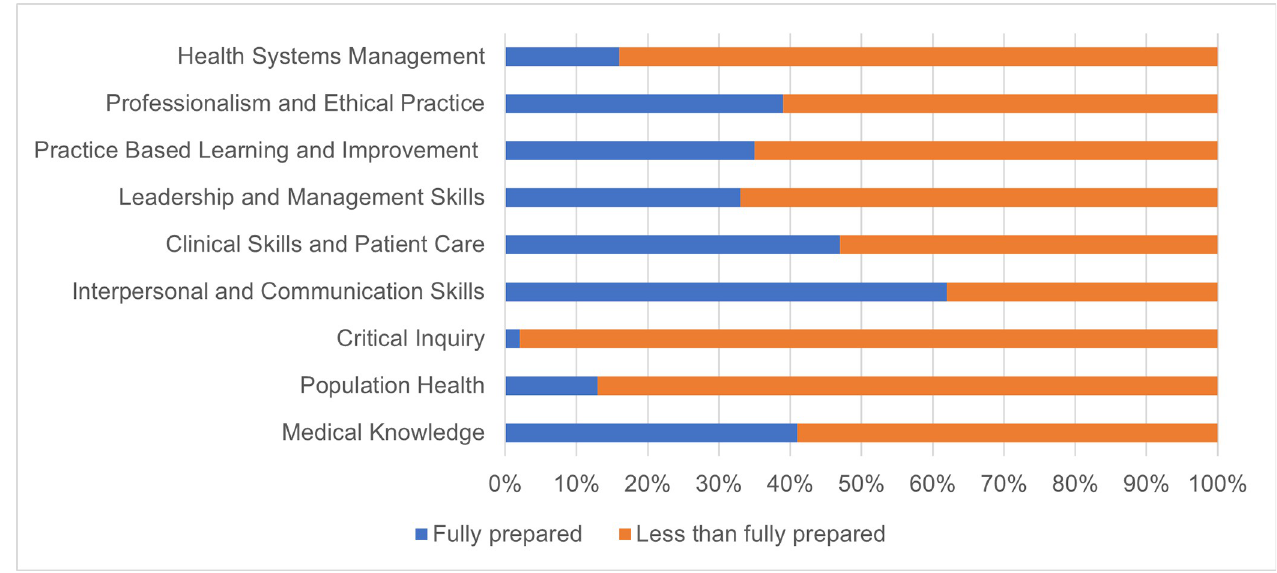
Fig 7. AMD graduates’ self-assessment of nine physician